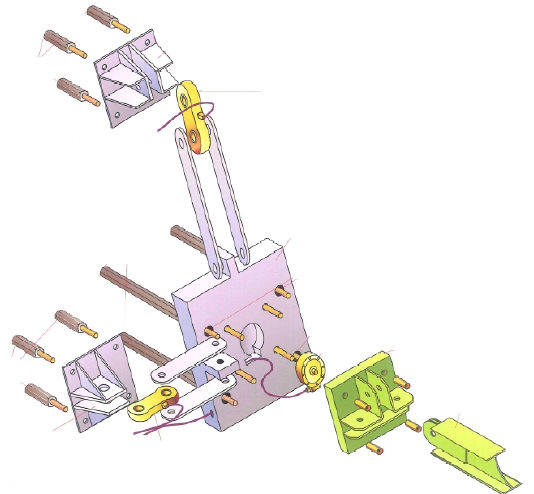
Figure 6. Patented measurement system for loads in the case of hinged steel posts and the ground plate orthogonal and parallel to the ground (source: